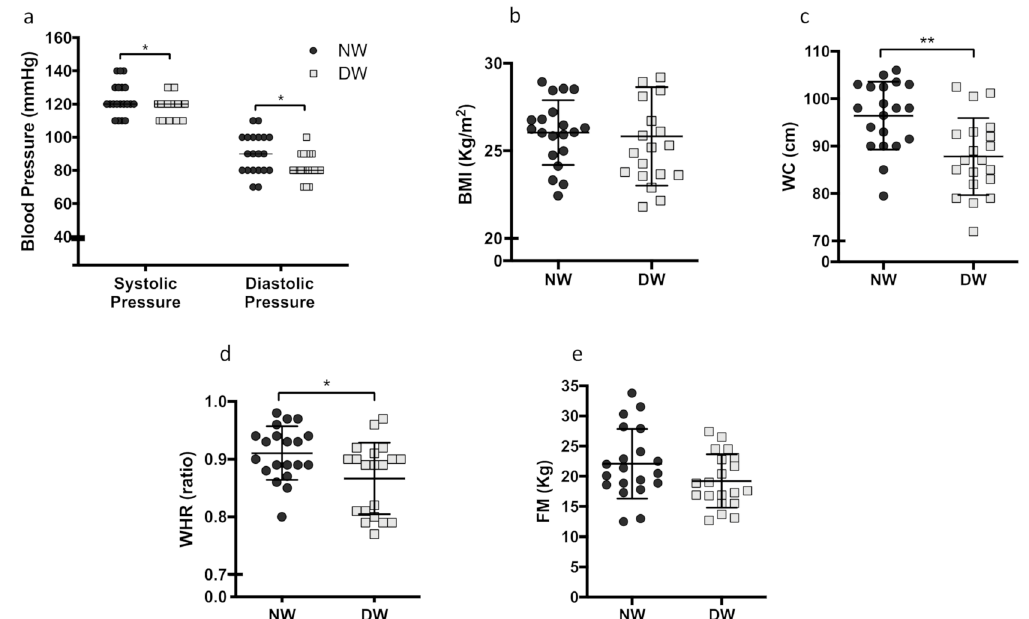
Figure 2. Blood pressure analysis and anthropometric parameters at day and night workers. ( a ) The blood pressure of day and night workers was verified after 20 min of total rest. Systolic pressure ( p = 0.0496), Diastolic pressure ( p = 0.0172), ( b ) BMI assessment ( p = 0.7801), ( c ) Measurement of waist circumference ( p = 0.0010), ( d ) Waist–hip ratio ( p = 0.0153), ( e ) Quantification of fat mass ( p = 0.0887). Data are presented as box plot or dot plot with mean. Unpaired, one-tailed t -test. * p < 0.05, ** p < 0.01. ( n = 20 per